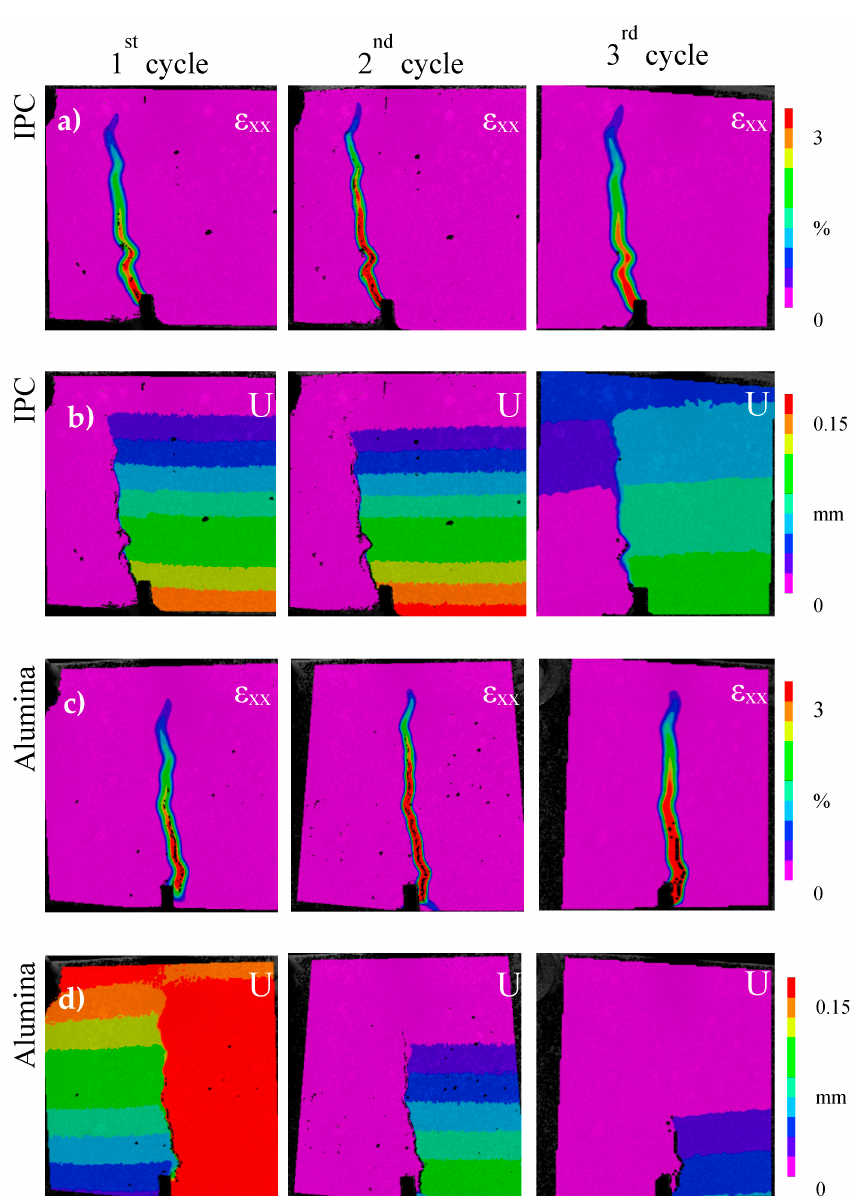
Figure 3. Strain ( ε xx) and deformation (U) maps of the beam’s side at the end of the each loading cycle: ( a , b ) cementitious (IPC); and ( c , d ) ceramic (alumina)